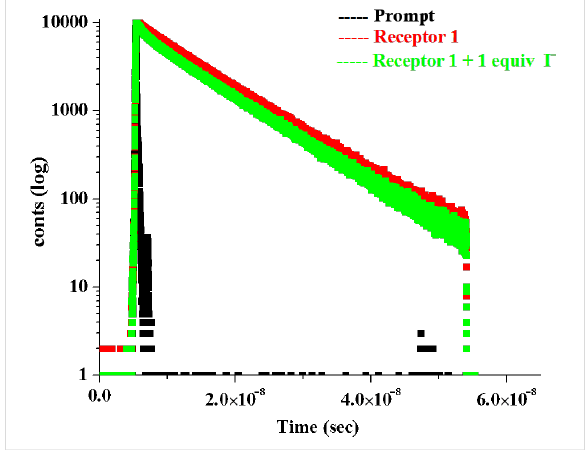
Figure 14: Fluorescence decays (at λ max = 420 nm) of receptor 1 upon the addition of I − ion ([ H ] = 5.78 × 10 − 5 M, [ G ] = 4.55 × 10 − 3 M) in CHCl 3 containing 0.1% CH 3